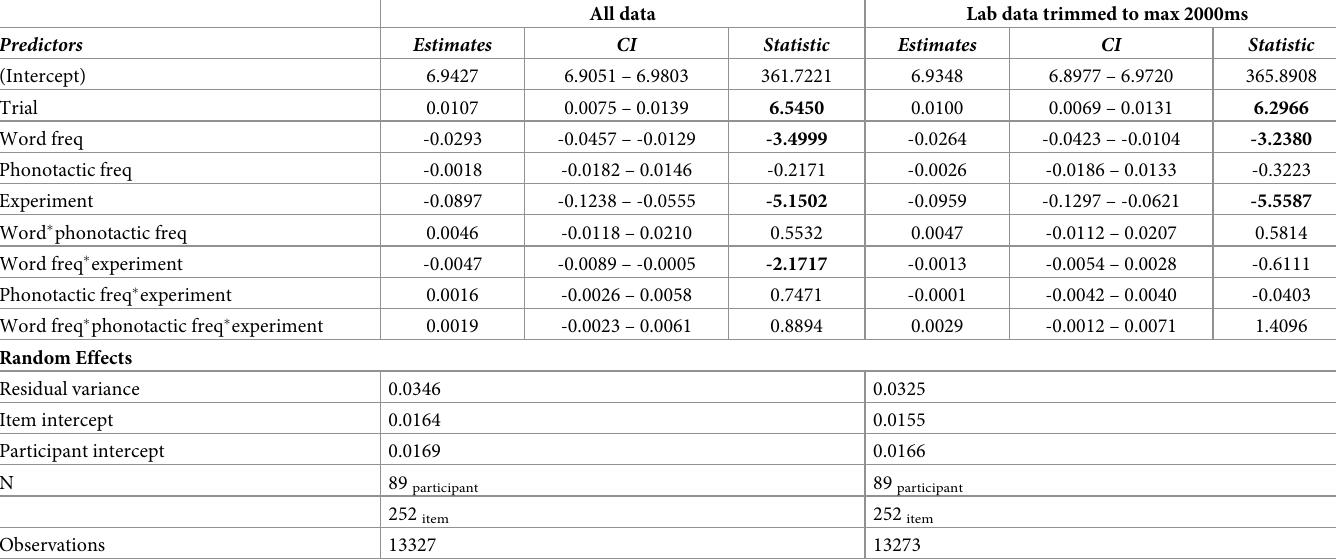
Table 2. Linear mixed model outputs of latency analyses across the internet and lab